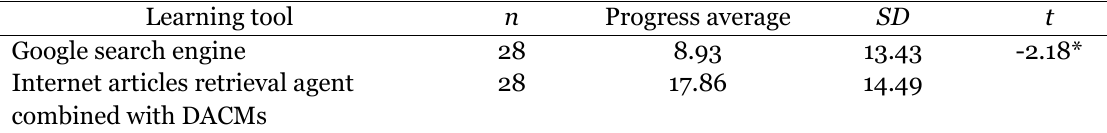
The Paired Sample t Test Results for Using the Different Learning Tools Learning tool